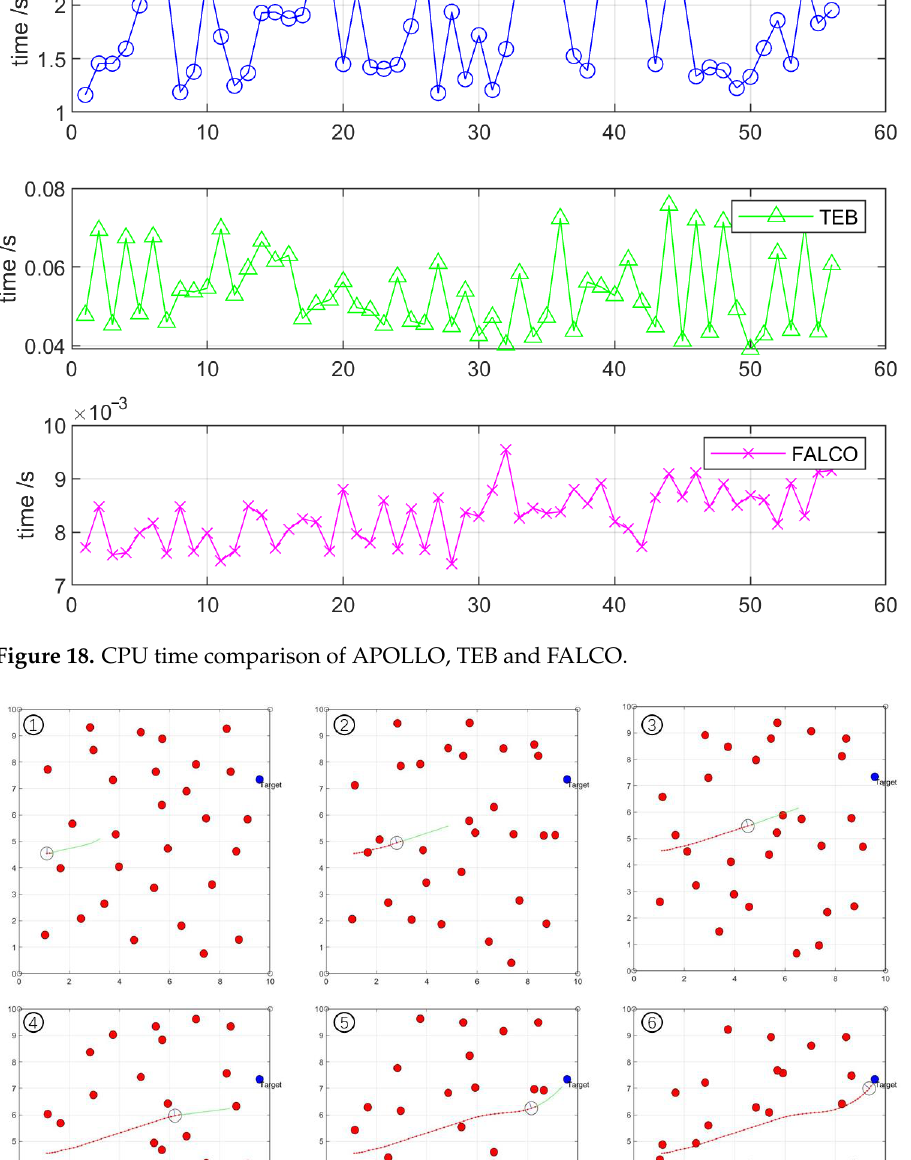
Figure 19. Trajectory generation process in the human-involved dynamic driving scenario. Red dots represent the randomly walking humans, and the hollow circle represents the vehicle. The number ① – ⑥ indicate six sequential moments from the beginning to the end.